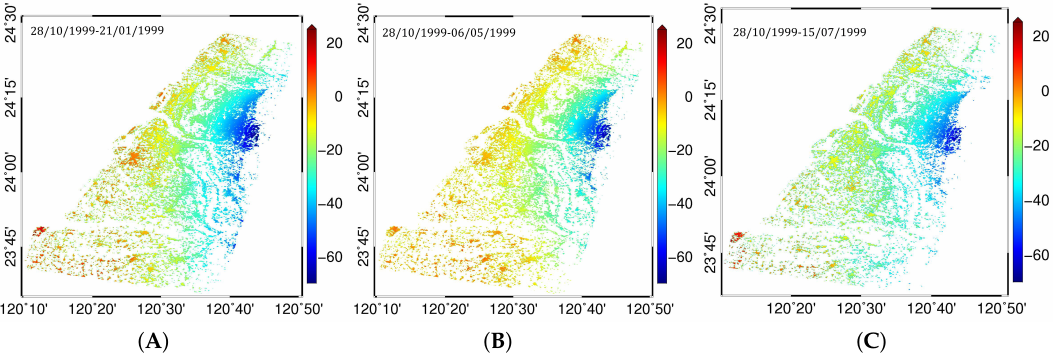
Figure 4. Interferograms of the Chi-Chi earthquake (color bar in cm) as presented in Table 1, the primary image is on 28 October 1999. ( A ) 28/10/1999-21/01/1999. ( B ) 28/10/1999-06/05/1999. ( C )